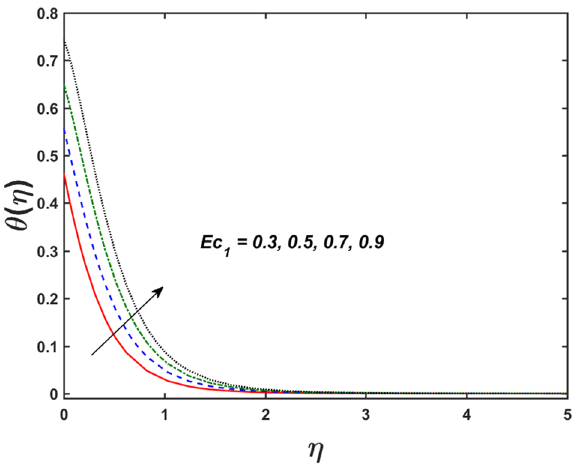
Figure 5. Variation in θ(η) for M and Ec 1 .